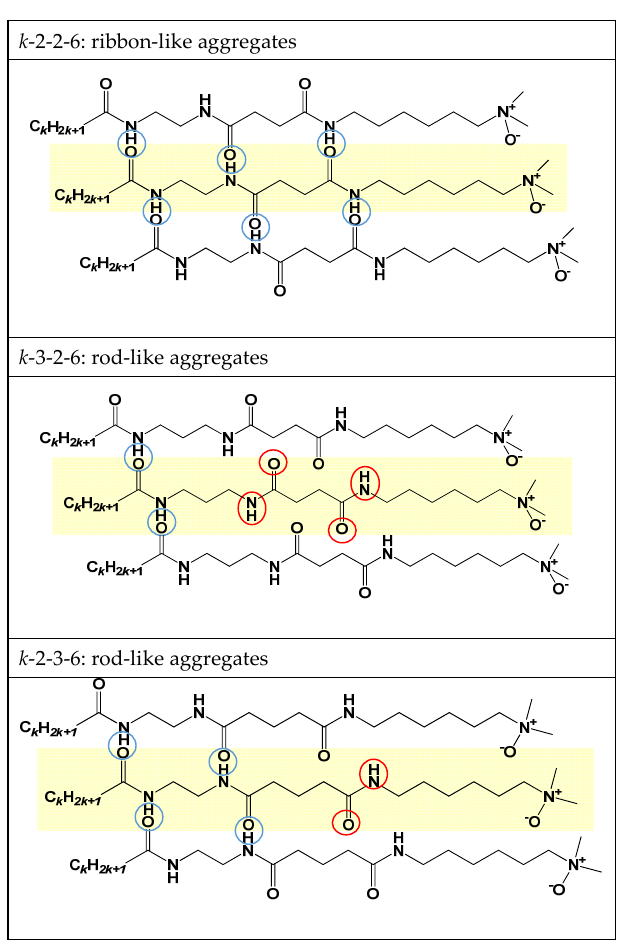
Figure 11. Schematic of the odd–even effect of hydrogen bonding formation. Blue circles indicate hydrogen bonds between neighboring AAO molecules. Red circles indicate amide groups without hydrogen bonds.